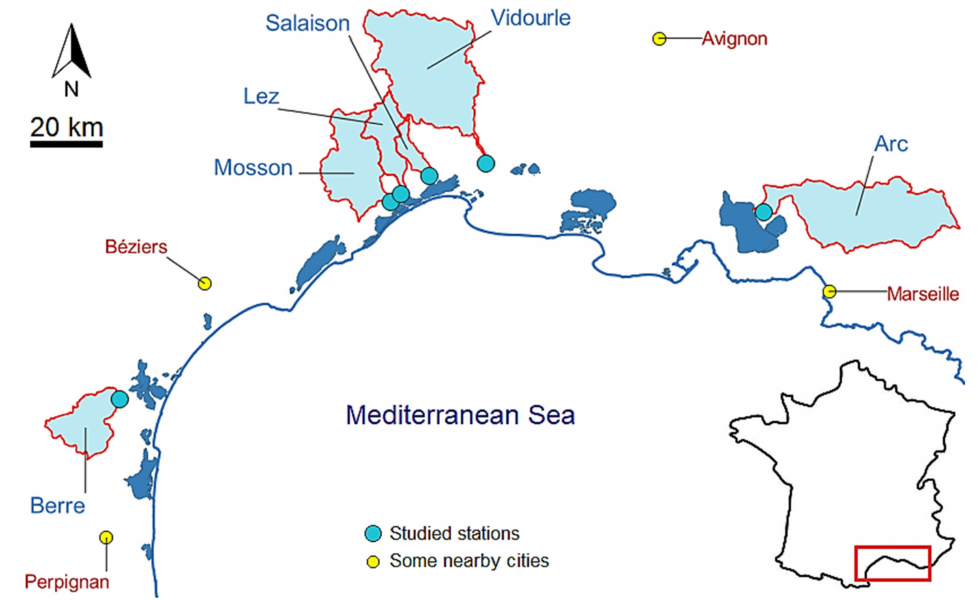
Figure 1. Location of the studied watersheds and monitoring stations (Names in blue indicate watersheds studied; names in red indicate major cities in the